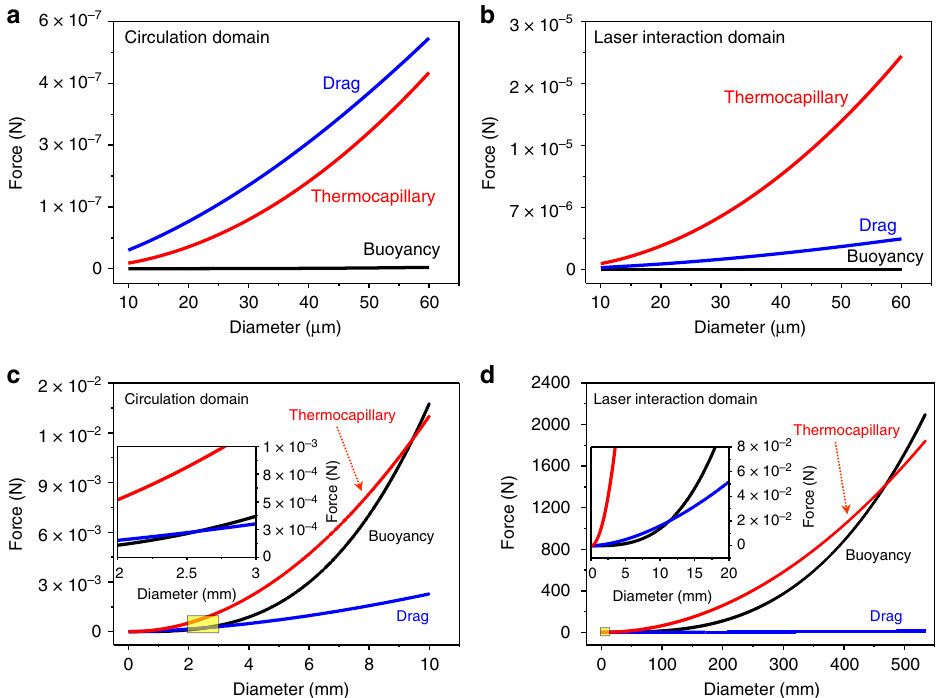
Fig. 4 Force analysis. a , b Comparison of drag force, buoyant force and thermocapillary force at the circulation domain ( a ) and the laser interaction domain ( b ) for the pore size range studied in this work. c , d Forces as a function of pore diameter. The critical pore size for buoyant force to overcome drag force is 2.5 mm at the circulation domain ( c ) and 11 mm at the laser interaction domain ( d ), which are even larger than the size of a typical melt pool in the LPBF process. The critical pore size for buoyant force to be larger than the thermocapillary force is even larger, 9.5 mm at the circulation domain ( c ) and 470 mm at the laser interaction domain ( d ). The inset (in c and d ) corresponds to the area marked by the yellow